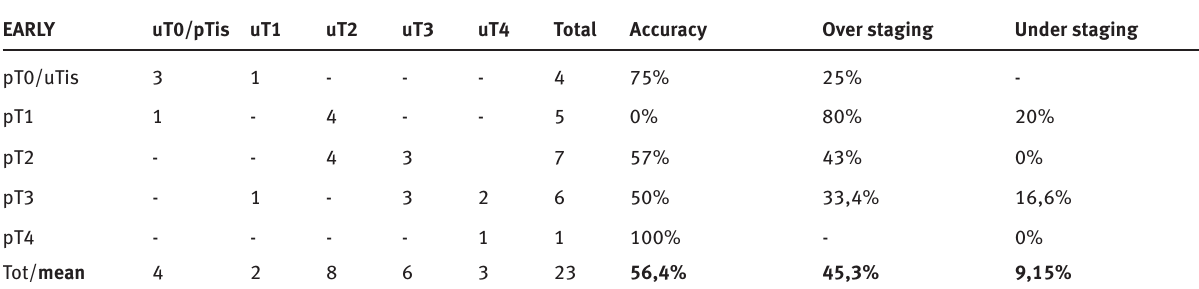
Table 1 : Accuracy, overstaging and substaging risk for T stages – Early group